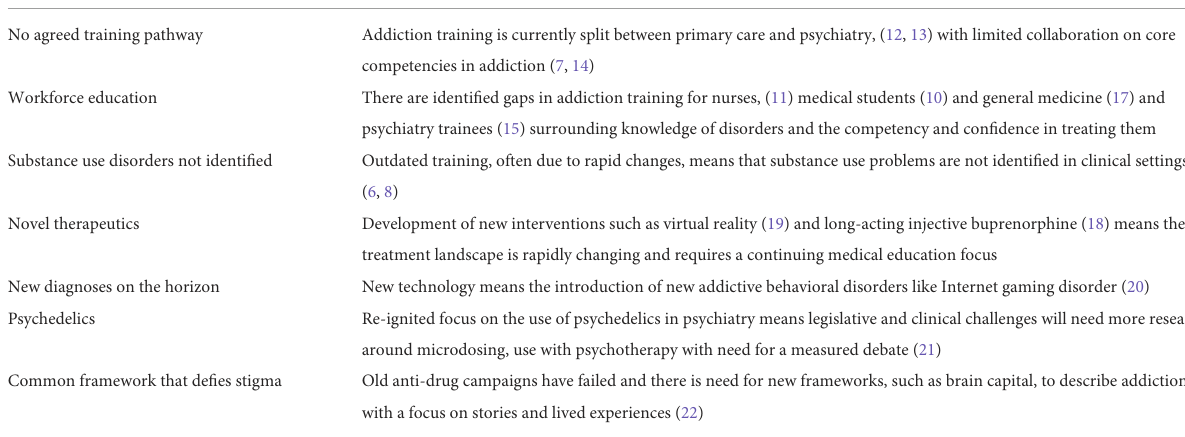
TABLE 1 Overview of key challenges facing addiction training in